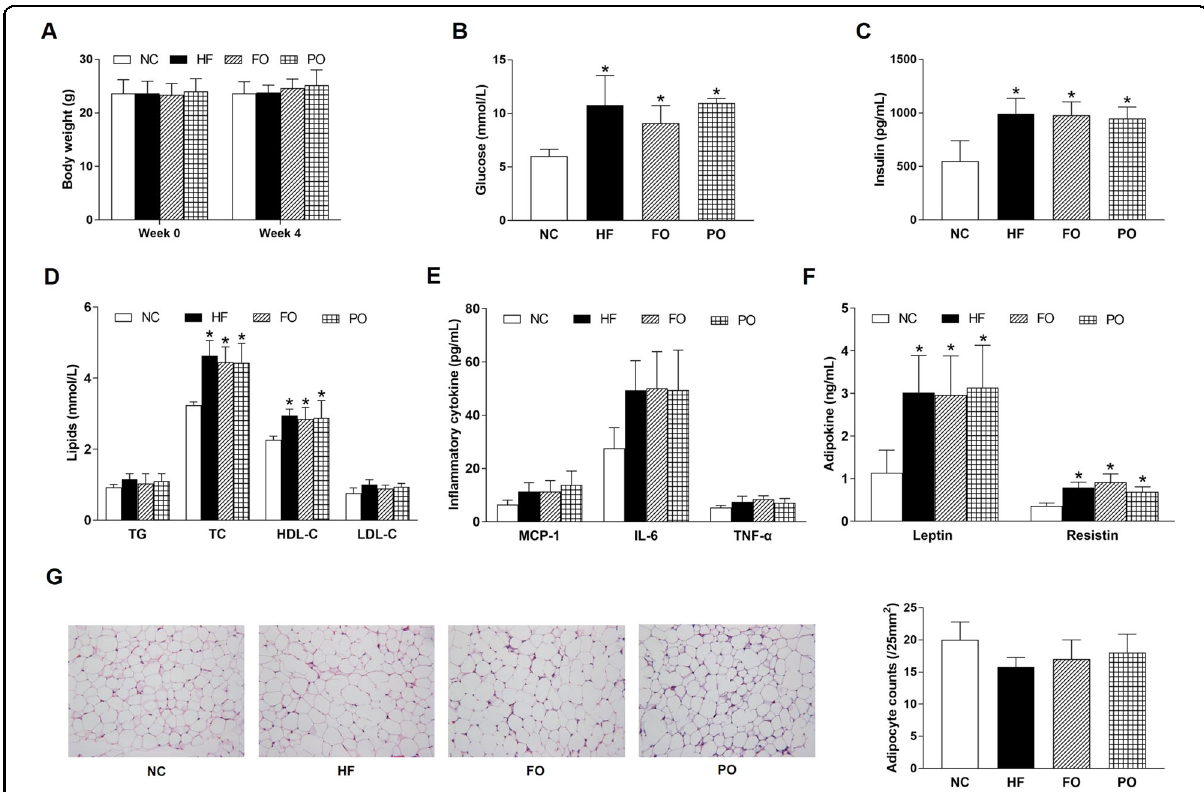
Fig. 3 Effects of FO and PO on glucolipid metabolism, in fl ammation, and adipokine in MyD88 − / − mice. A Body weight; B glucose; C insulin; D lipids; E in fl ammatory cytokine; F adipokine; G representative hematoxylin and eosin-stained images (left) and adipocyte counts (right) in adipose tissue. NC normal chow, HF high fat, FO fi sh oil, PO perilla oil, TG triglyceride, TC total cholesterol, HDL-C high-density lipoprotein cholesterol, LDL-C low-density lipoprotein cholesterol, MCP-1 monocyte chemotactic protein-1, IL-6 interleukin-6, TNF- α tumor necrosis factor- α . Data are presented as the mean ± standard deviation. * P < 0.05, compared with NC; # P < 0.05, compared with HF; & P < 0.05, compared with